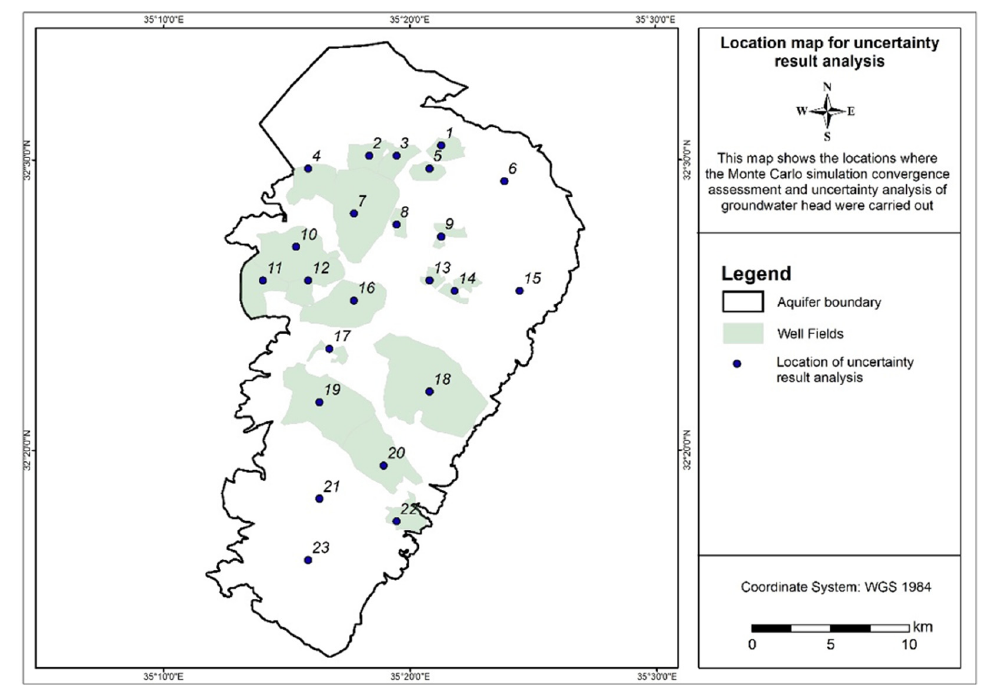
Figure 10. Locations used for Monte Carlo Simulations convergence assessment.